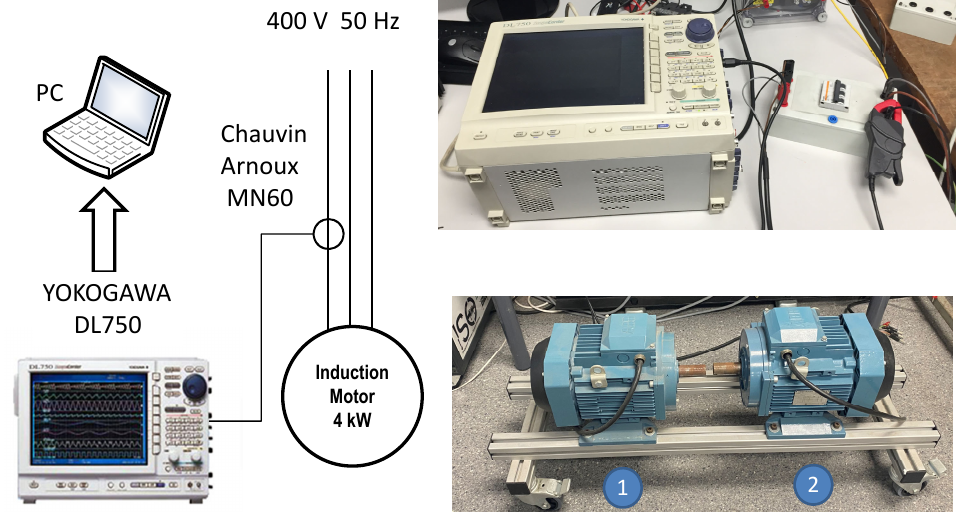
Figure 21. Test rig used for the experimental validation of the proposed approach. Two motors of the same type as the simulated one, labelled as (1) and (2) in the right , bottom part of the Figure, have been experimentally tested. To avoid the influence of the coupling on the eccentricity measurement, both motors have been tested uncoupled and powered directly form the mains, as shown in the schema ( left ). The current has been recorded using a Chauvin Arnoux MN60 current probe (see Appendix B) and a Yokogawa DL750 ScopeCorder ( right , top ), at a rate of 10 kHz during an acquisition time of 100 s, to achieve a 0.01 Hz resolution in the current spectrum. The registered data have been stored and processed with the computer platform given in Appendix C.